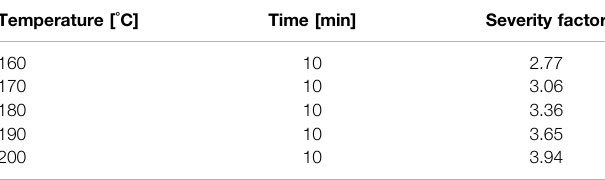
TABLE2| Compositionoftheusedlyophilizatesin%basedonthe fi